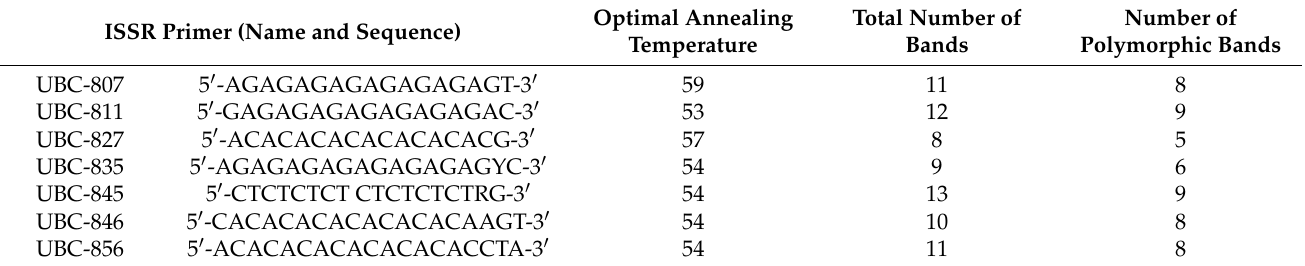
Table 7. ISSR primers studied for the study of genetic diversity of A. tinctoria